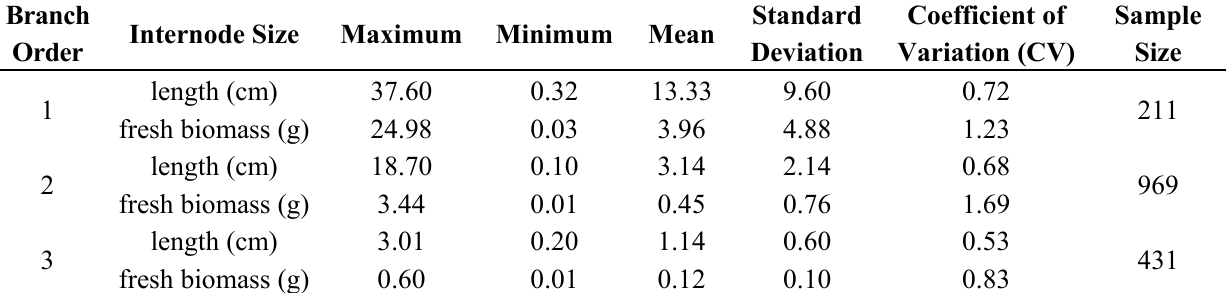
Table 2. Summary statistics of the last sampled internodes on Chinese pine branches. Branch